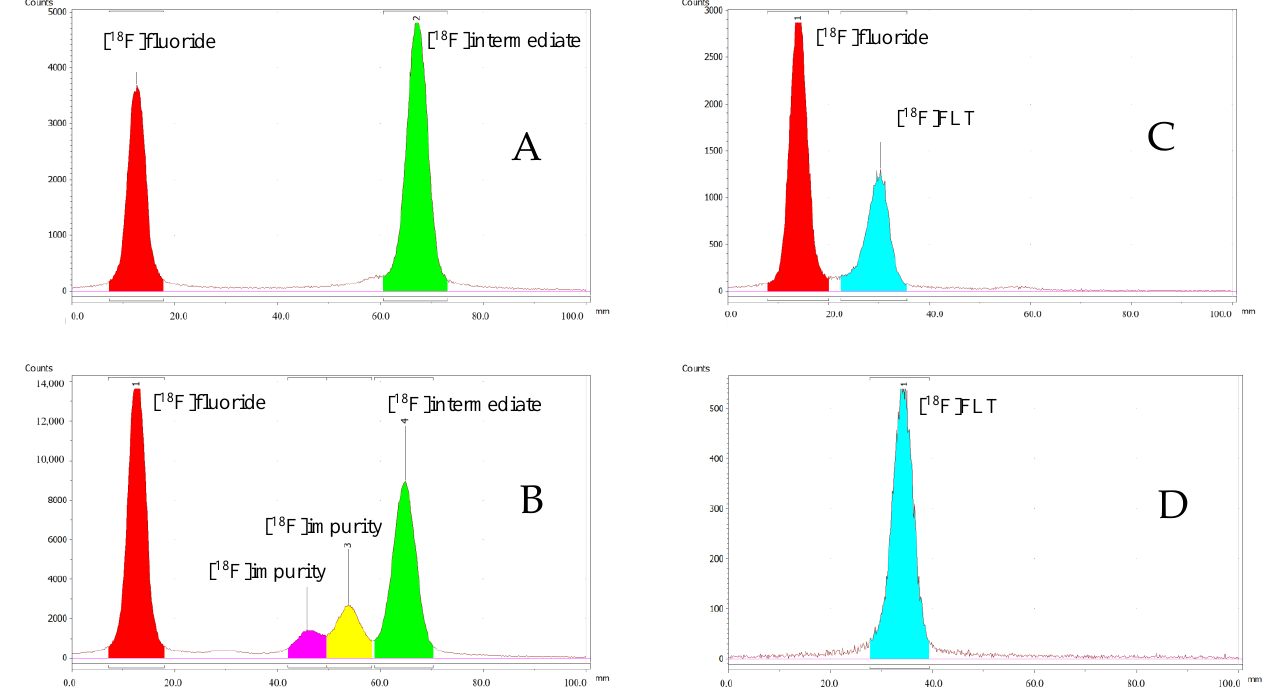
Figure 2. RadioTLC data for the synthesis of [ 18 F]FLT; eluent — ethyl acetate. ( A ) remote-controlled synthesis; reaction mixture after radiofluorination; 2.4 µmol, of I , 4.8 µmol of TBAOTs, 110 °C. 5 min. RCC 62%; ( B ) remote-controlled synthesis; reaction mixture after radiofluorination; 4.8 µmol, of I , 9.6 µmol of TBAOTs, 110 °C, 20 min; ( C ) automated synthesis; reaction mixture after hydrolysis; 2.4 µmol of I , 4.8 µmol of TBAOTs; the content of the [ 18 F]FLT in the reaction mixture 32%; ( D ) automated synthesis; [ 18 F]FLT, final formulation.